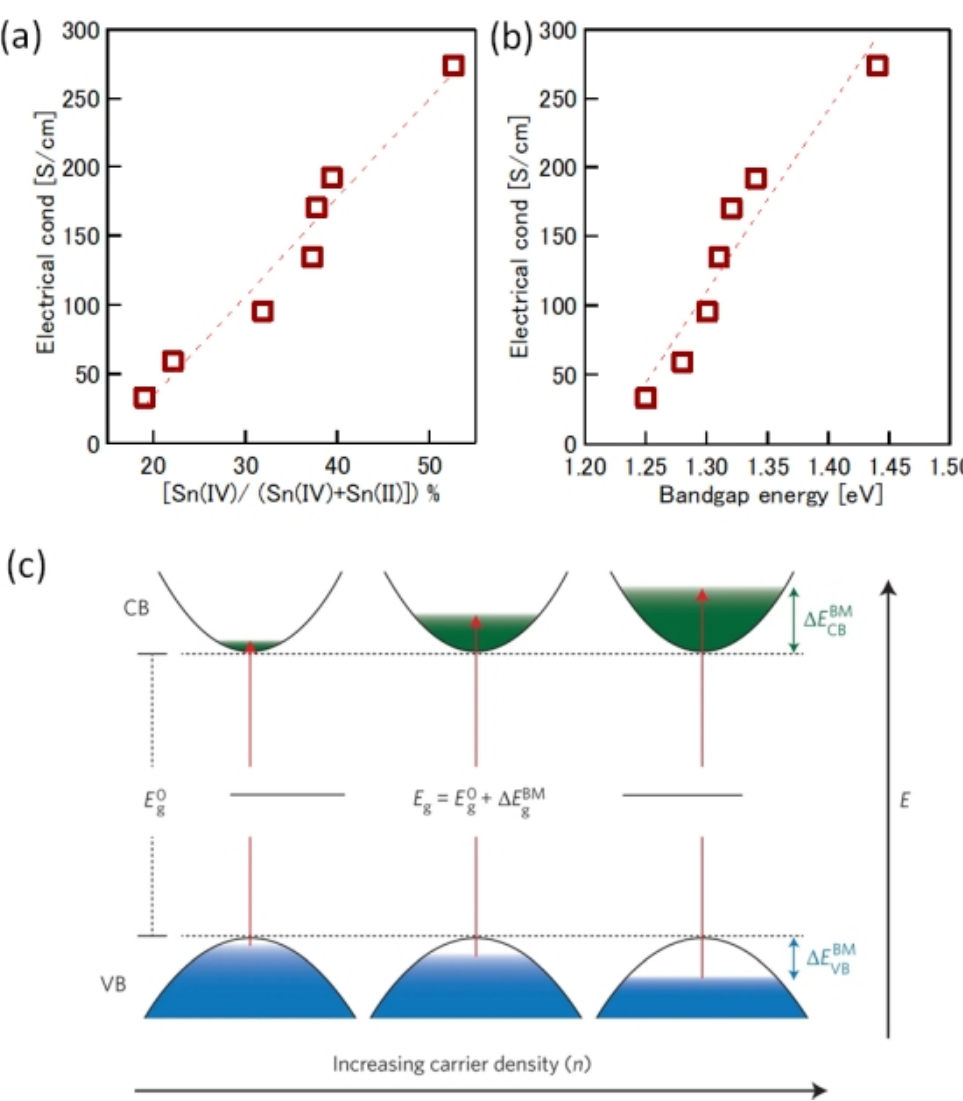
Figure 6. Correlation between ( a ) Sn 4+ and electrical conductivity, ( b ) bandgap energy and electrical conductivity. Reproduced with permission [40]. Copyright 2020, American Chemical Society. ( c ) Schematic representation of the Burstein–Moss effect showing the defects, bandgap, and charge carrier density relationship. Reproduced with permission [41]. Copyright 2014, Springer Nature.